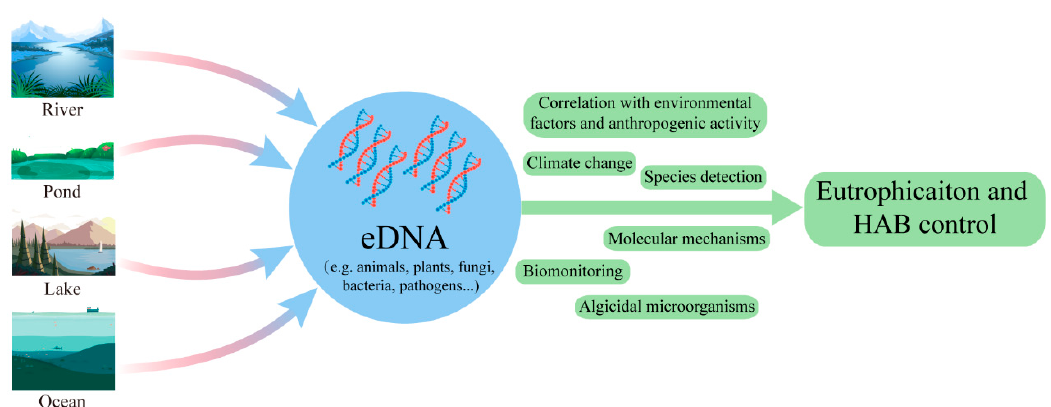
Figure 5. An overview of using eDNA as a tool for controlling and inhibiting eutrophication and HABs in aquatic ecosystems.